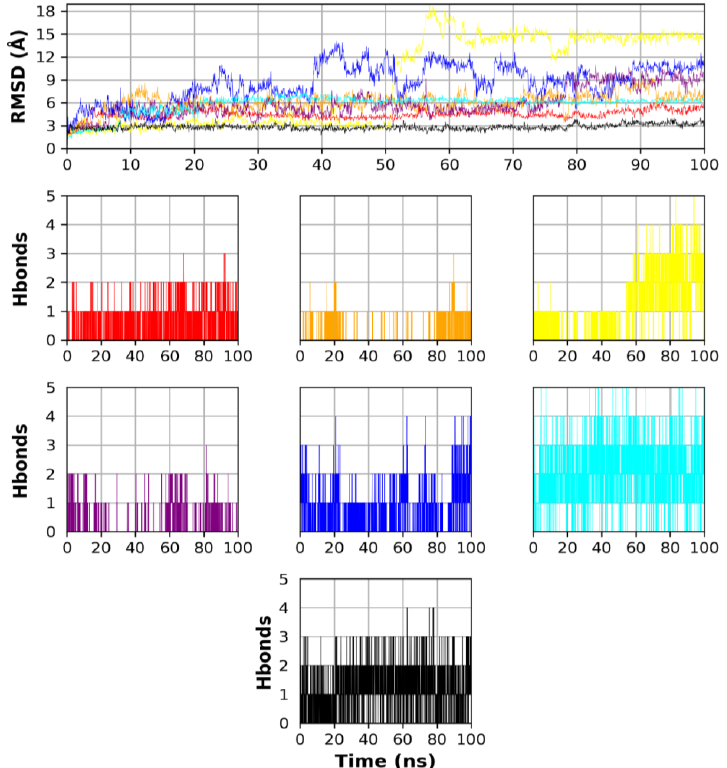
Figure 7. Ligand RMSD and hydrogen bond analysis. The graphs of Remdesivir, Lapatinib, and Fexofenadine are shown in red, orange, and yellow, respectively, while the graphs of NANPDB1, NANPDB2, NANPDB3, and Holoprotein are shown in purple, blue, cyan, and black, respectively.